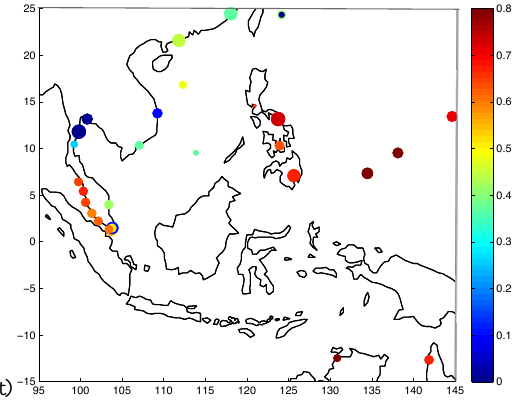
Figure 2. Correlation (averaged over each Southeast Asian sea) be- tween the HLK reconstruction and AVISO satellite altimetry data from 1993 to 2010.